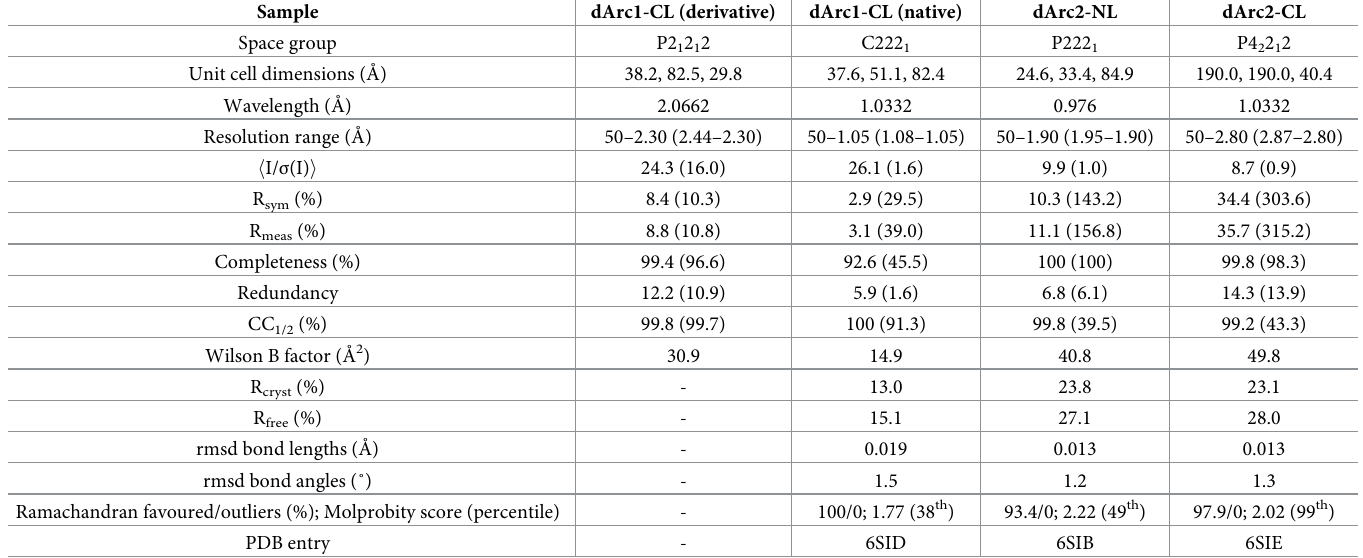
Table 1. Data processing and structure